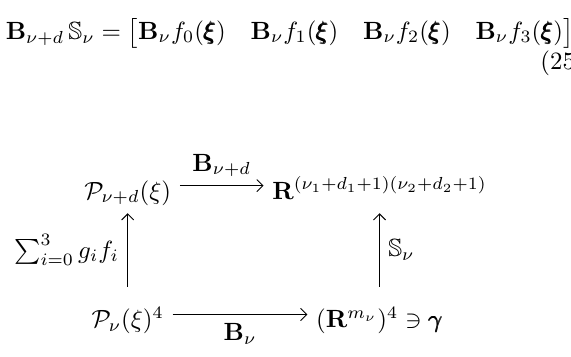
Figure 6: Diagram of the coordinate transformations